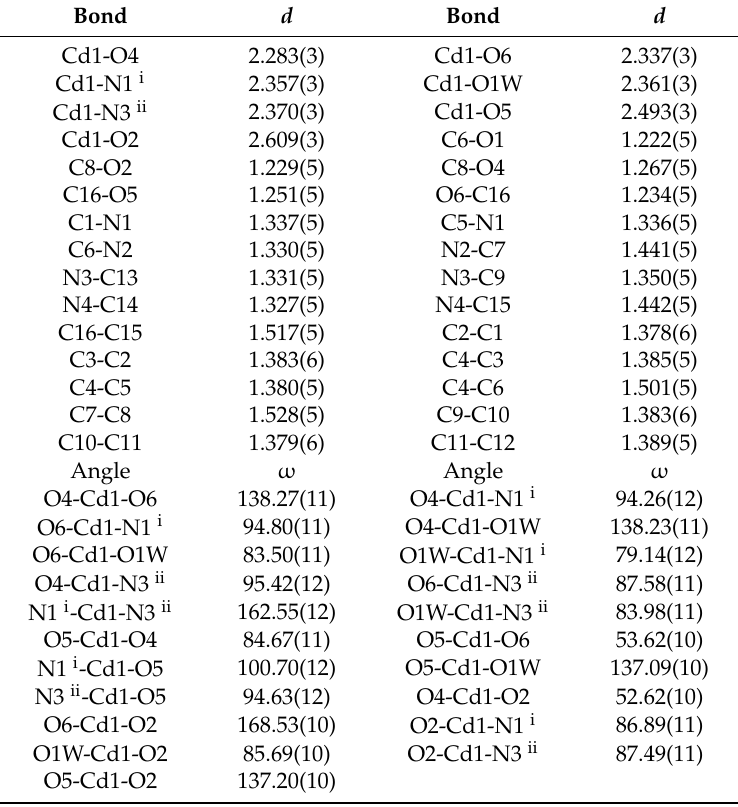
Table 1. Selected bond lengths d (Å) and bond angles ( ° ) for [{CdL 2 (H 2 O)}·(H 2 O) 3 ] n . Bond Bond d